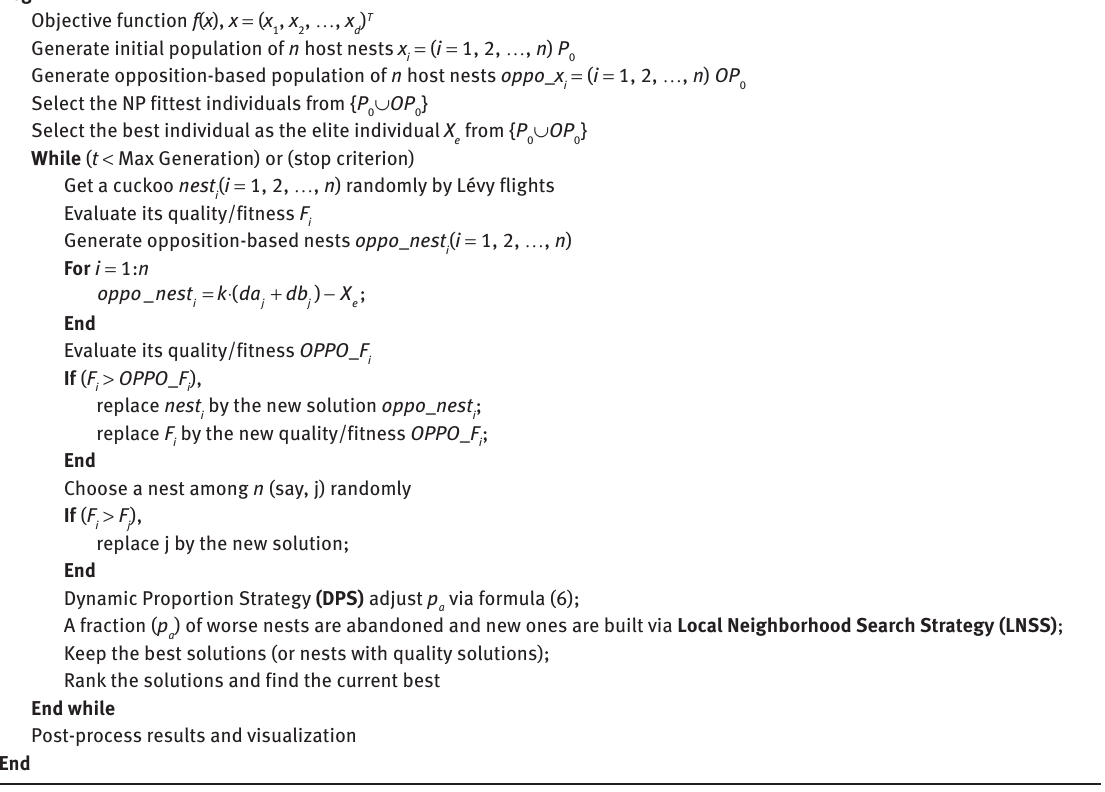
Algorithm 2. Cuckoo search with elite opposition-based strategy algorithm